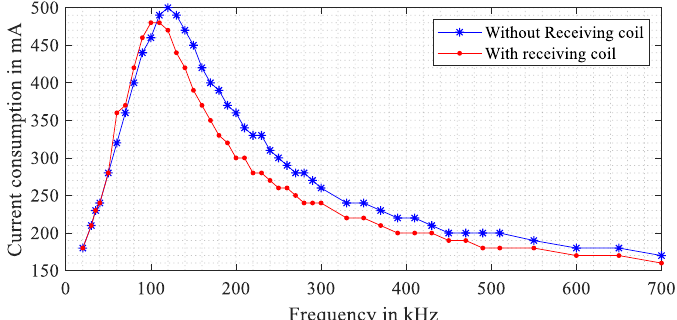
Figure 4. Primary side current consumption with and without the receiving side for different frequencies from 20 kHz to 700 kHz.